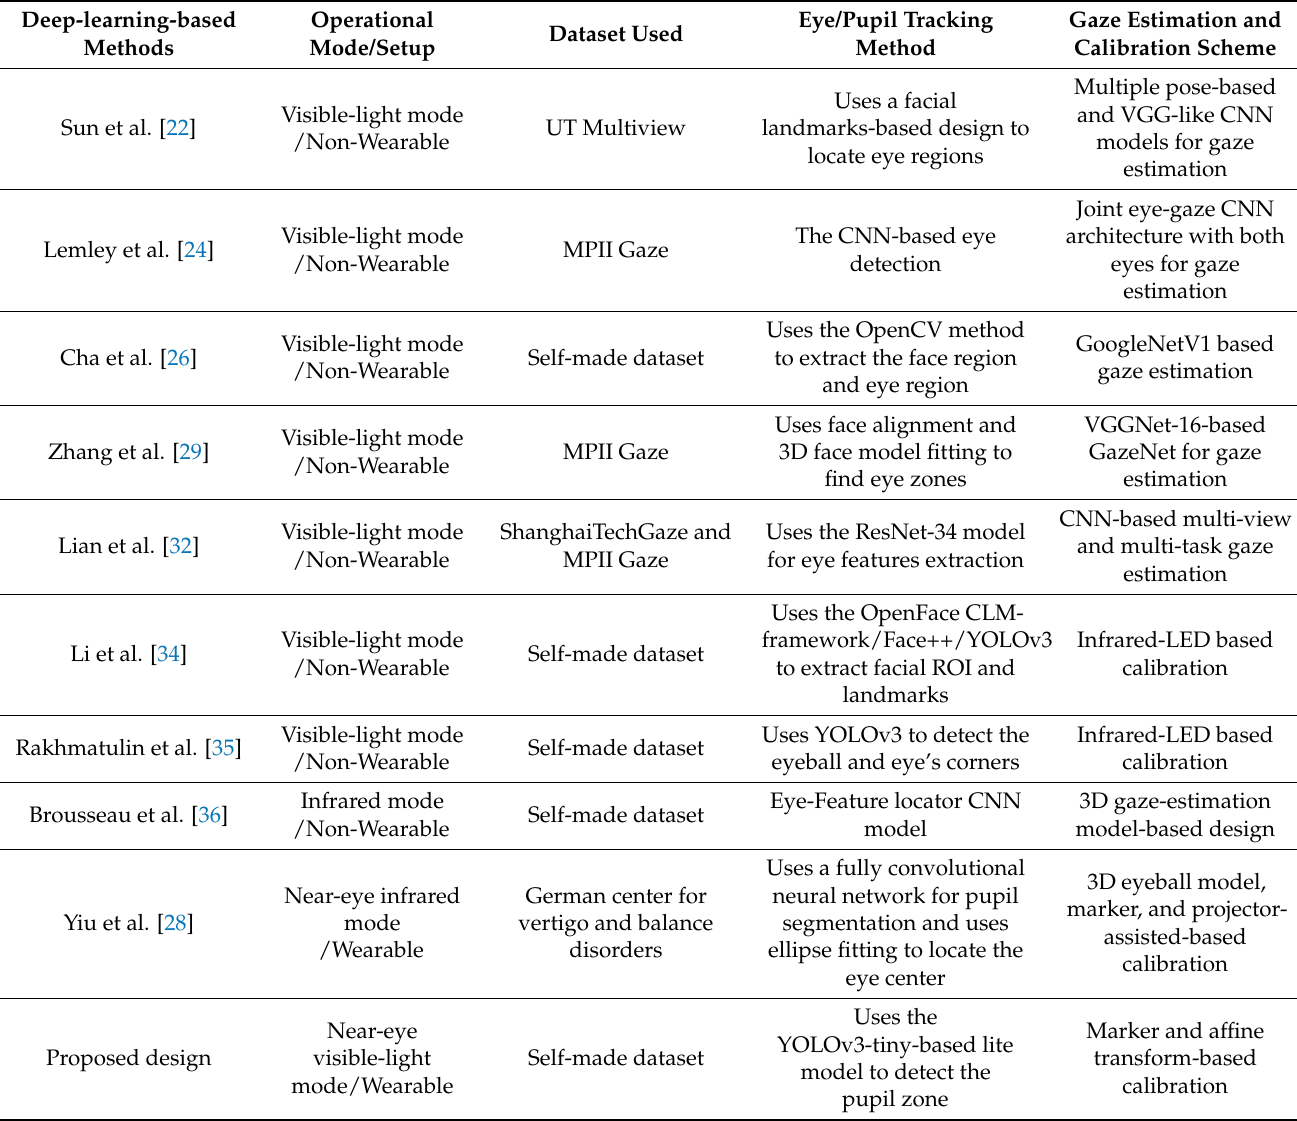
Table 1. Overview of the deep-learning-based gaze tracking